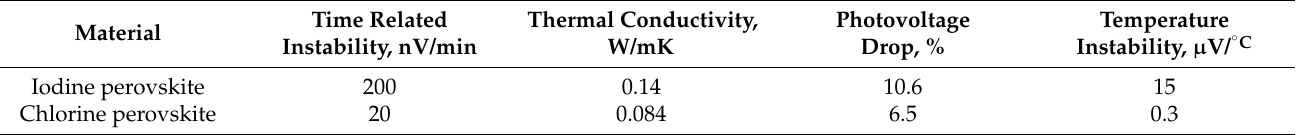
Table 2. Performance of the solar cells, comparing different stability indicators.